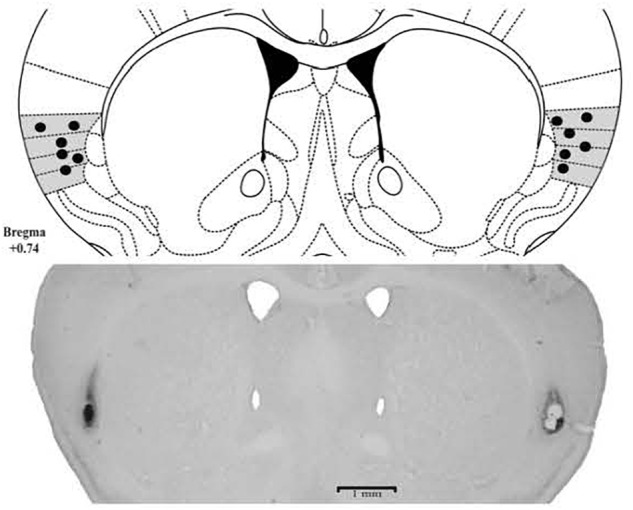
Photomicrographs and schematic representation of histological results according to the Atlas of Paxinos and Franklin (2001) in insula. The filled circles represent the sites of drug infusion.